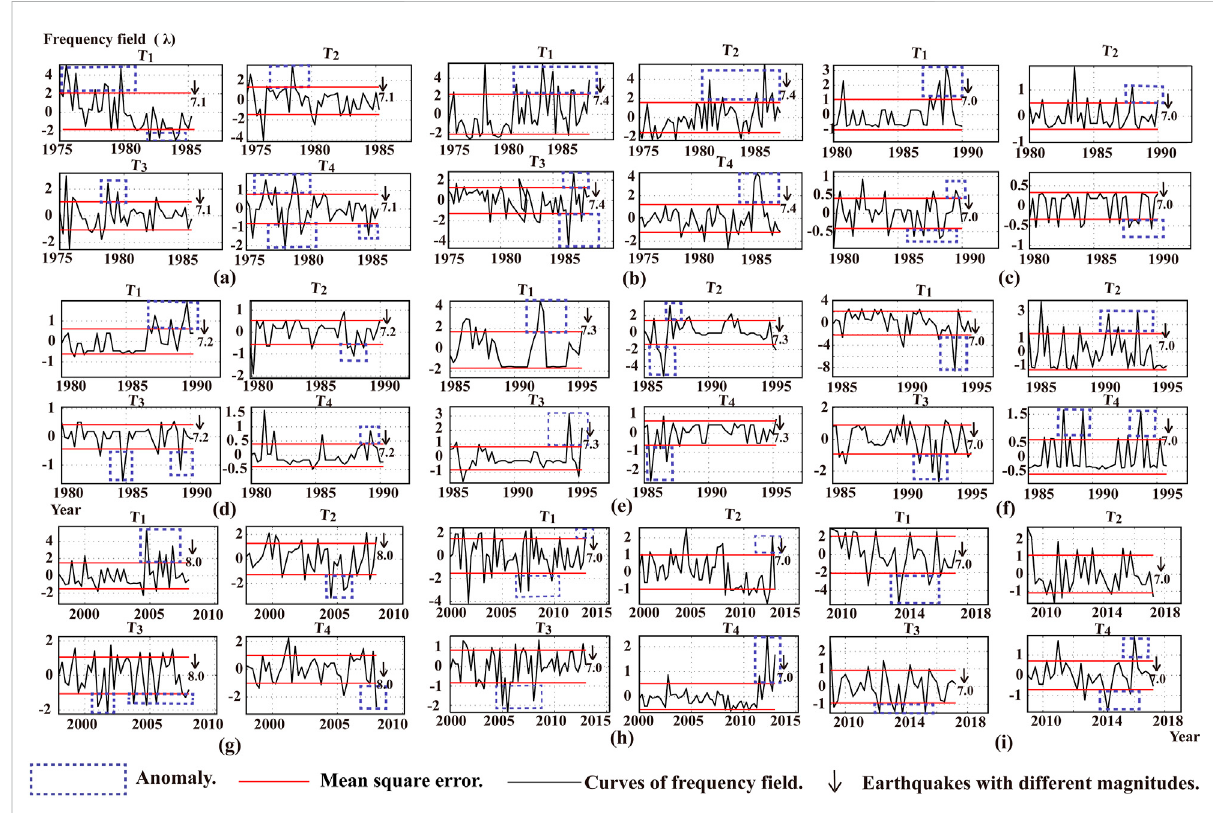
FIGURE 3 Temporal factors of the fi rst four frequency fi elds of 9 M s ≥ 7.0 earthquakes, The green dotted line represents the anomaly, The red line is two times the mean square error, The black arrow represents the magnitude of a M s ≥ 7.0 earthquake. (A) 1985 M s 7.1 Wuxia earthquake; (B) 1988 M s 7.6 Lancang – Gengma earthquake; (C) 1990 M s 7.0 Gonghe earthquake; (D) 1990 M s 7.2 Jeminay earthquake; (E) 1995 M s 7.3 Myanmar – China earthquake; (F) 1996 M s 7.0 Lijiang earthquake; (G) 2008 M s 8.0 Wenchuan earthquake; (H) 2013 M s 7.0 Lushan earthquake; (I) 2017 M s 7.0 Jiuzhaigou